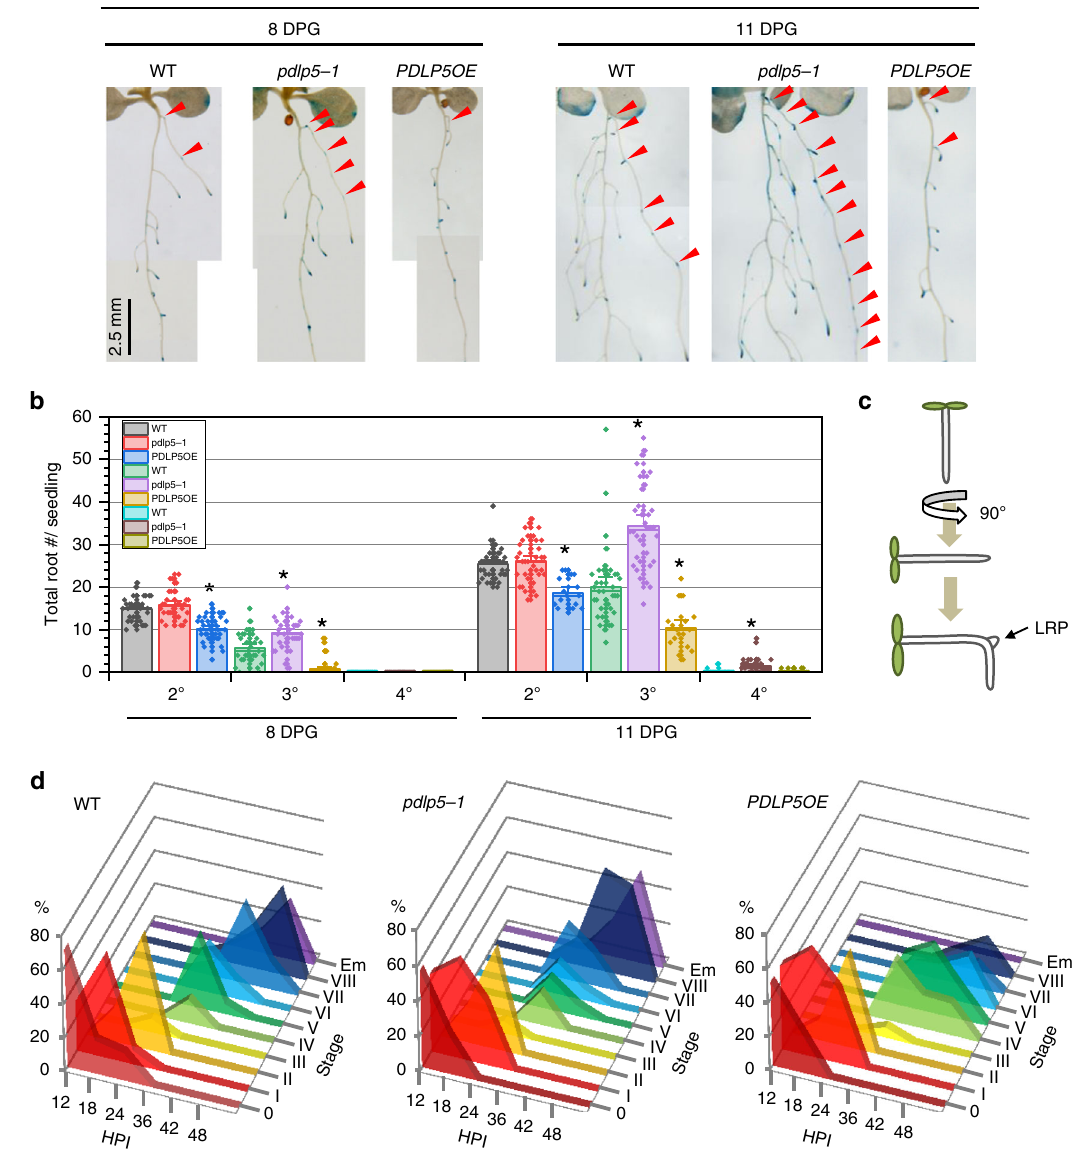
Fig. 3 PDLP5 is required for normal LR emergence. a LR development in WT, pdlp5-1 , and PDLP5OE expressing DR5:GUS . Arrowheads, tertiary roots. b Quanti fi cation of total lateral root numbers (both emerged and un-emerged secondary [2°], tertiary [3°], and quaternary [4°] roots). n ≥ 30 per seedling set. Bars, standard deviation. Asterisks, signi fi cance determined by student T -test ( P < 0.01). c A diagram depicting the gravitropic assay and position of the root bend LRP. d Time-course of LRP development and emergence at the root bend of 4-day-old seedlings following gravistimulation. x -axis, hrs post- induction (hpi); y -axis, LRP developmental stage; z -axis, distribution of LRP at different stages per time point; n ≥ 20 seedlings per